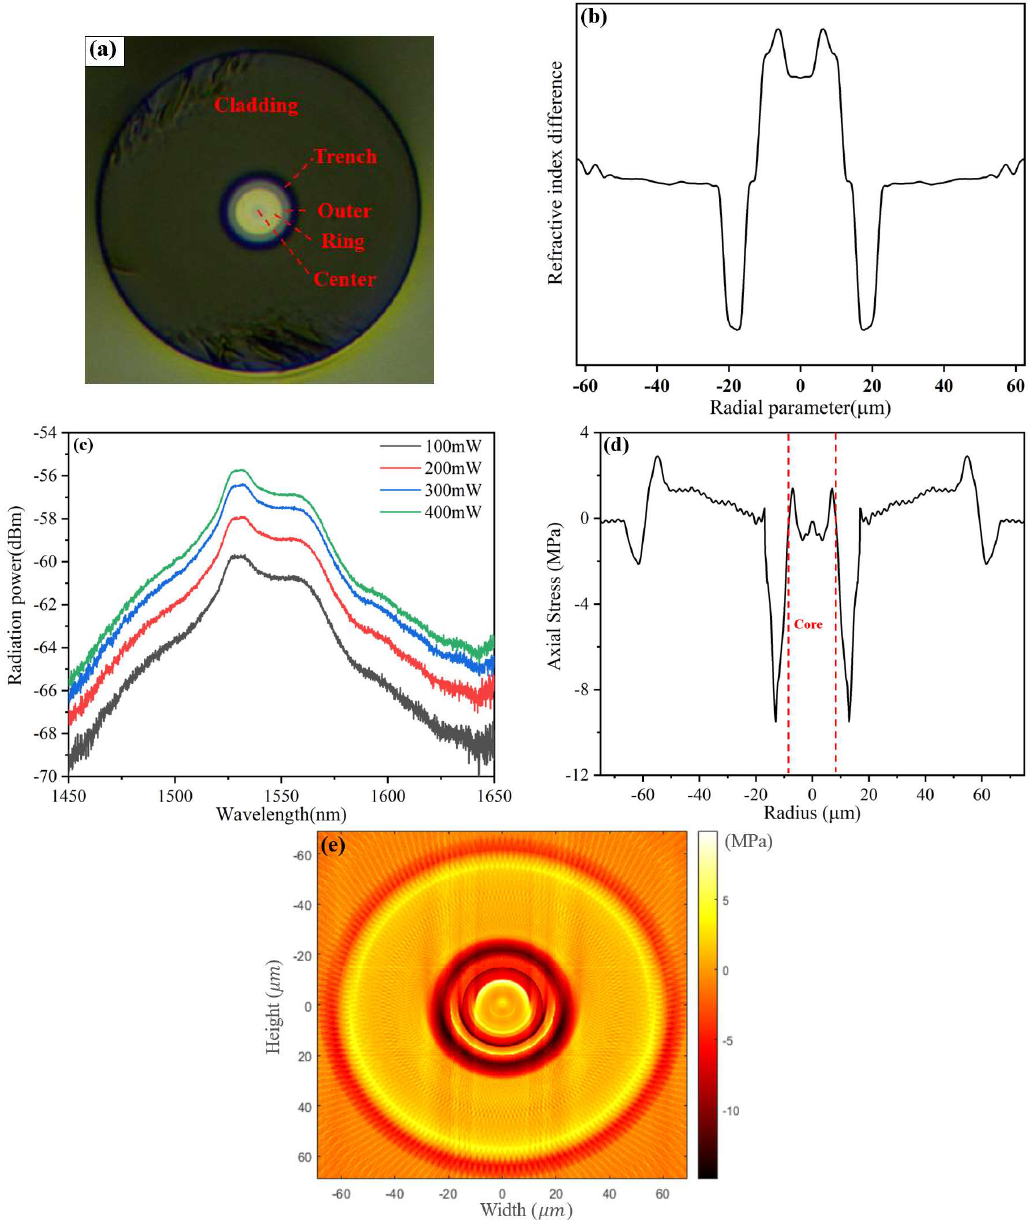
Figure 6. ( a ) Cross section, ( b ) RI profile, ( c ) spontaneous emission spectrum, and ( d ) one-dimensional residual stress and ( e ) two-dimensional residual stress distributions on the cross section of FM-EDF-